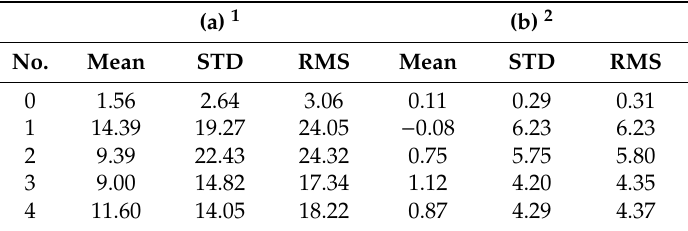
Table 3. ( a ) Statistics of the di ff erence between the multibeam bathymetry and the seafloor topography estimated from gravity gradients using simulated annealing; ( b ) Statistics of the di ff erence between the measured gravity gradients and the one forward computed from the seafloor topography